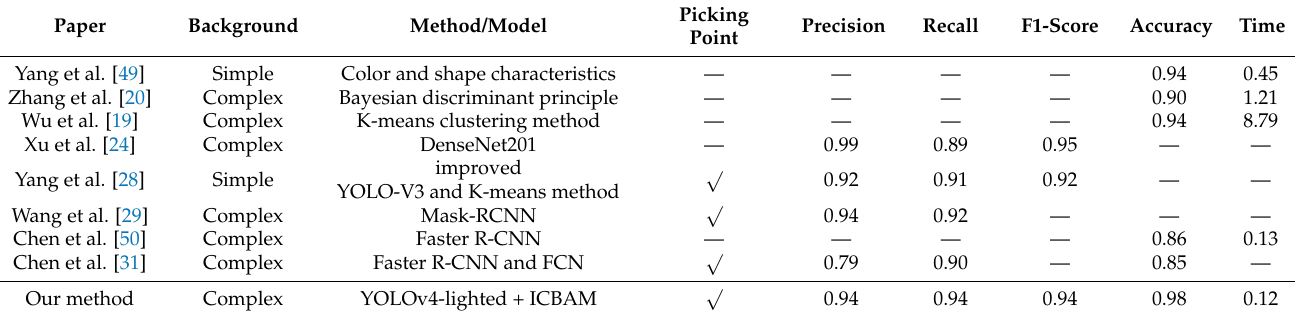
Table 6. Results in this paper compared with results from other state-of-the-art